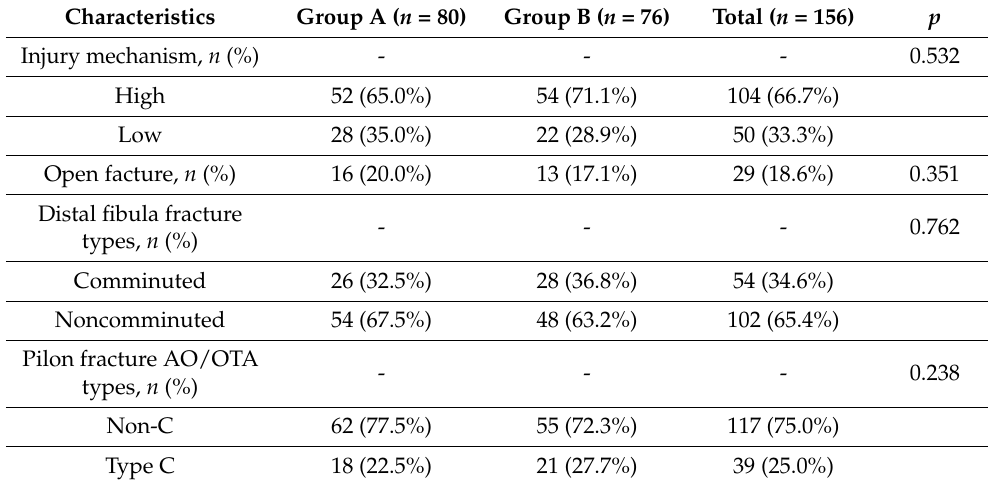
Table 2. Injury characteristics and fracture types of pilon fractures and distal fibula